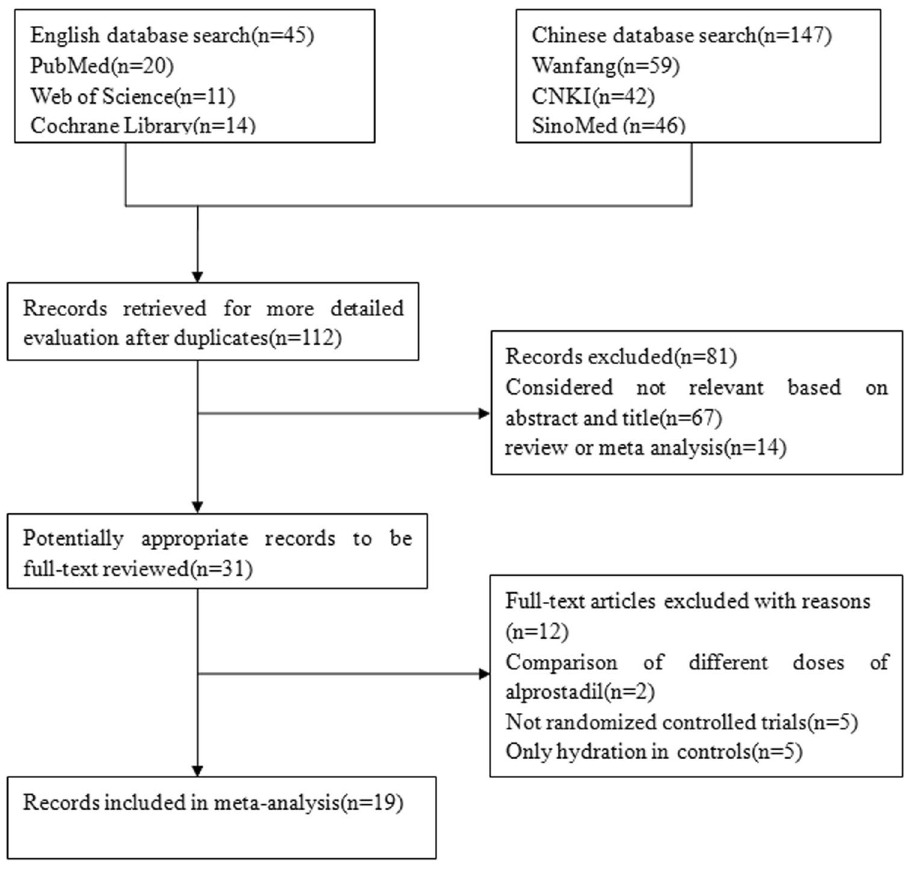
Figure 1. Flow diagram of study